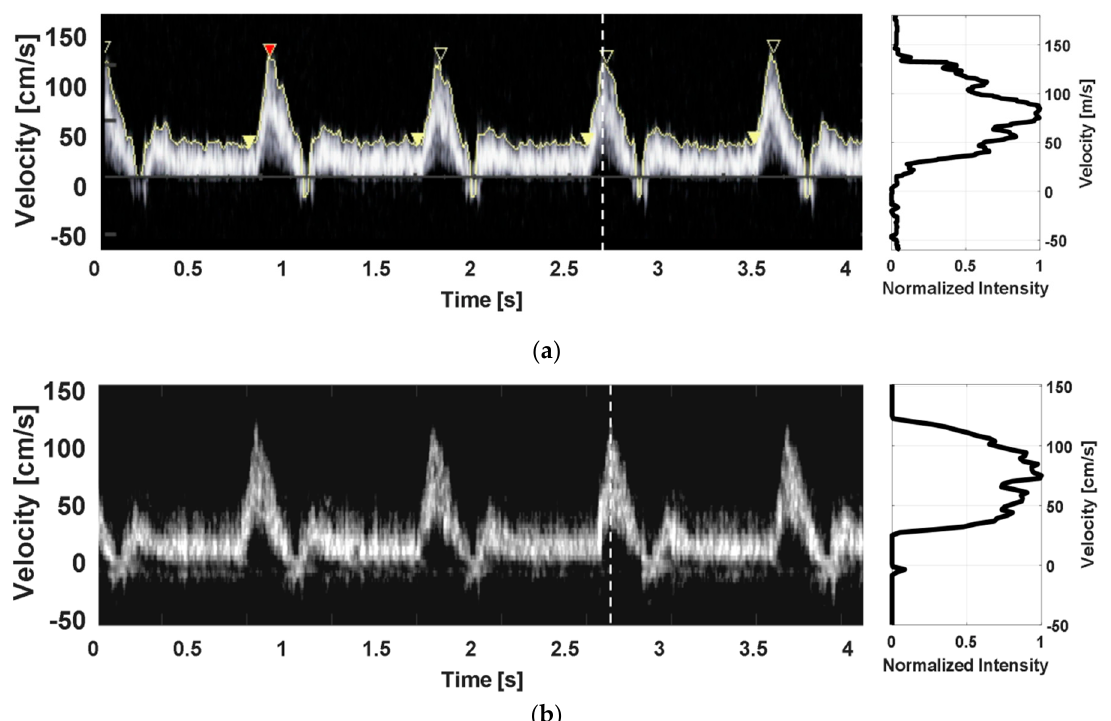
Figure 5. Doppler spectrogram obtained from ( a ) the commercial rack-based ultrasound machine (i.e., Accuvix V10, Samsung Medison Co., Seongnam, South Korea) and ( b ) the developed wireless carotid wearable ultrasound Doppler system prototype (PRF = 4 KHz). The velocity profile at a peak systolic phase, indicated by a white dotted line, is given in the right side of each Doppler spectrogram.